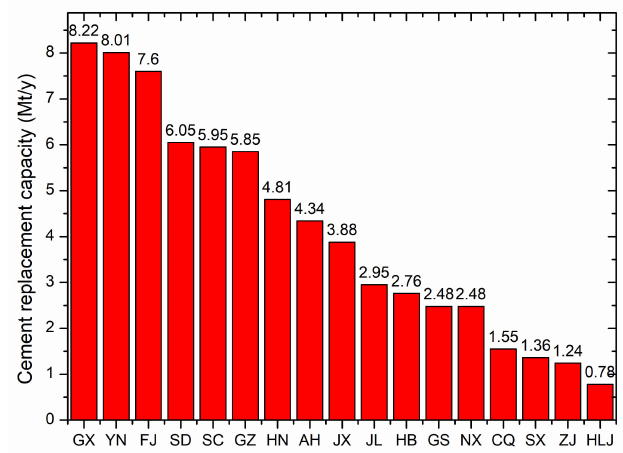
Figure 5. Cement replacement capacity by province in 2020. GX is Guangxi, YN is Yunnan, FJ is Fujian, SD is Shandong, SC is Sichuan, GZ is Guizhou, HN is Hunan, AH is Anhui, JX is Jiangxi, JL is Jilin, HB is Hubei, GS is Gansu, NX is Ningxia, CQ is Chongqing, SX is Shaanxi, ZJ is Zhejiang, and HLJ is Heilongjiang (reproduced according to [93]).